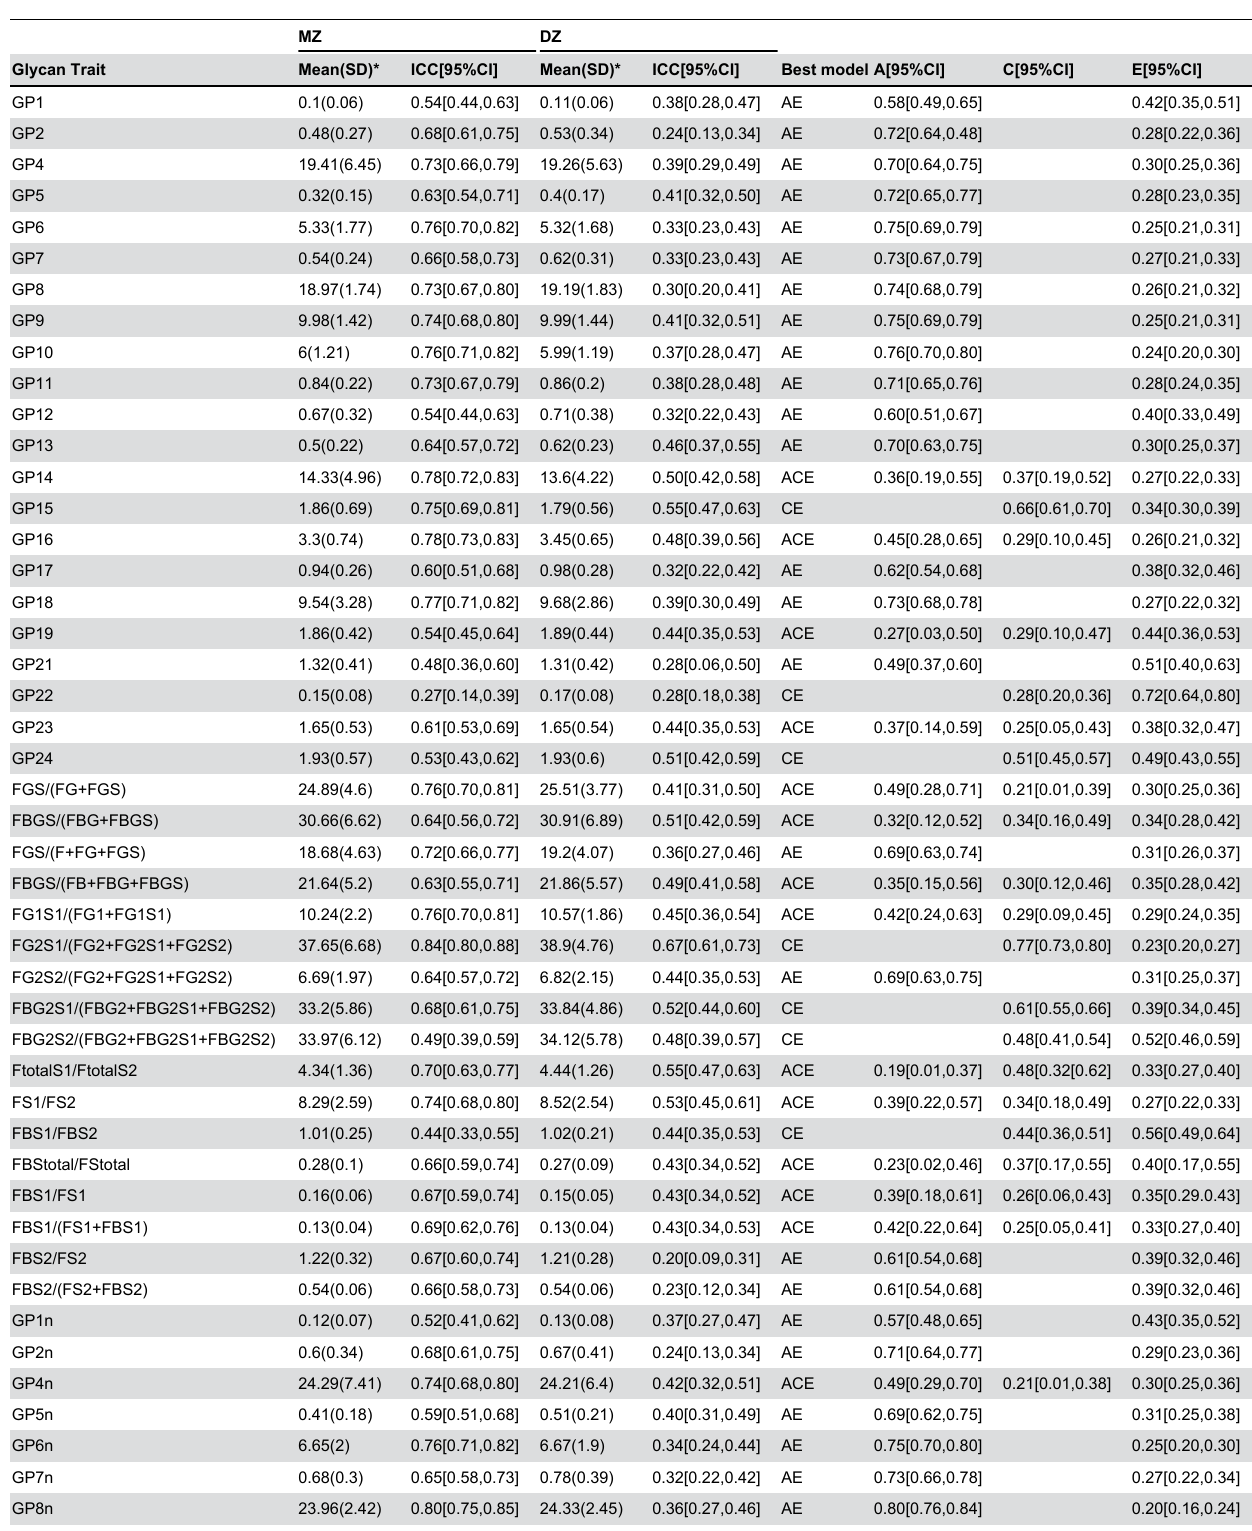
Table 2. Heritability estimates and 95% confidence intervals for IgG glycan traits adjusted for age and batch.